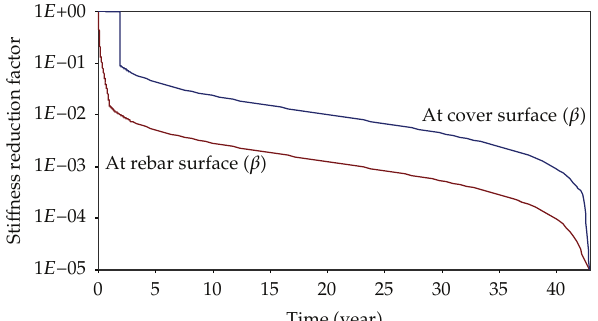
Figure 8: Hoop sti ff ness reduction factor (cid:5) β (cid:6) at rebar surface and at cover surface with time t .